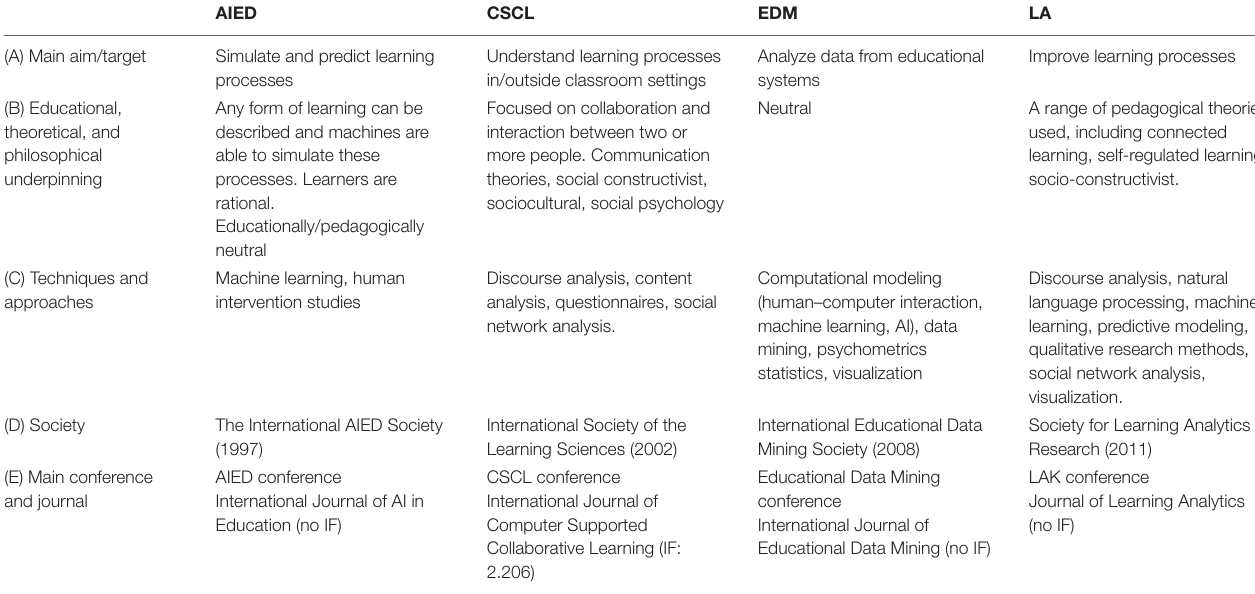
TABLE 1 | Overview of the four research fields of education and